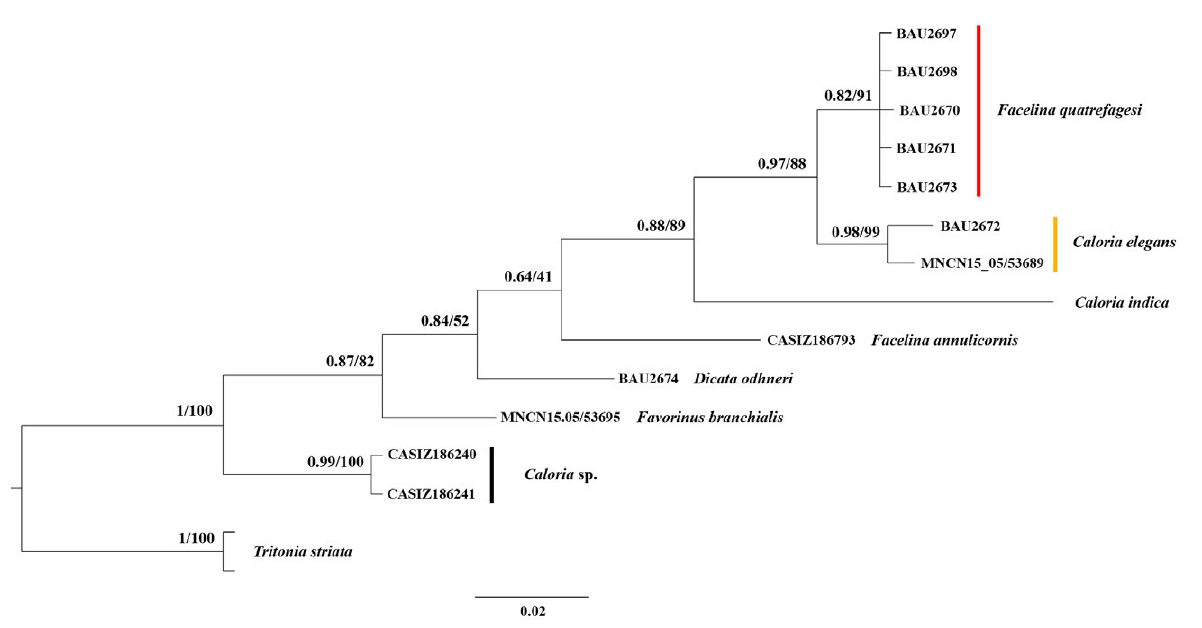
Fig. S2. – Phylogenetic relationships among facelinid species based on the Bayesian analysis of single nuclear gene dataset (H3). Numbers at nodes are Bayesian posterior probability and ML bootstrap support,